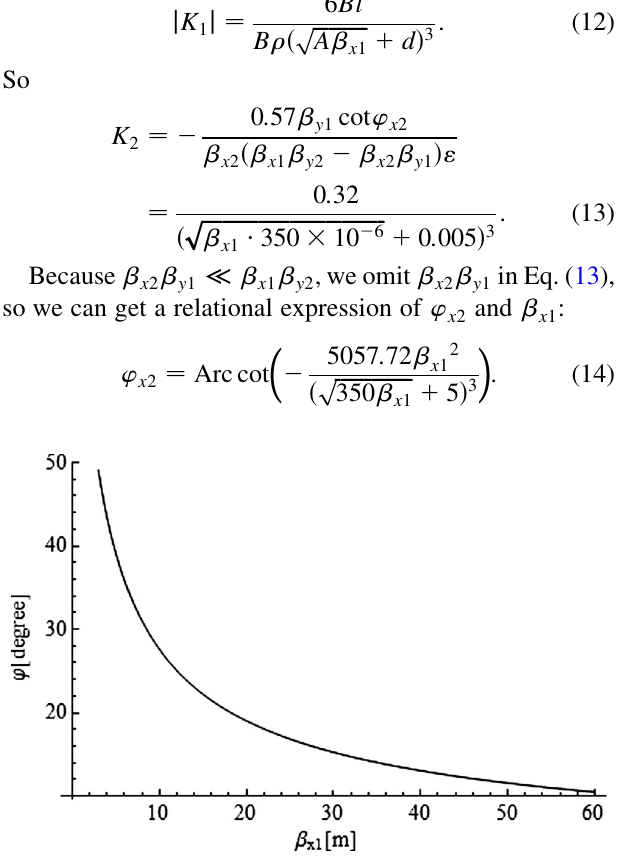
FIG. 4. The relational graph of ’ and (cid:3)